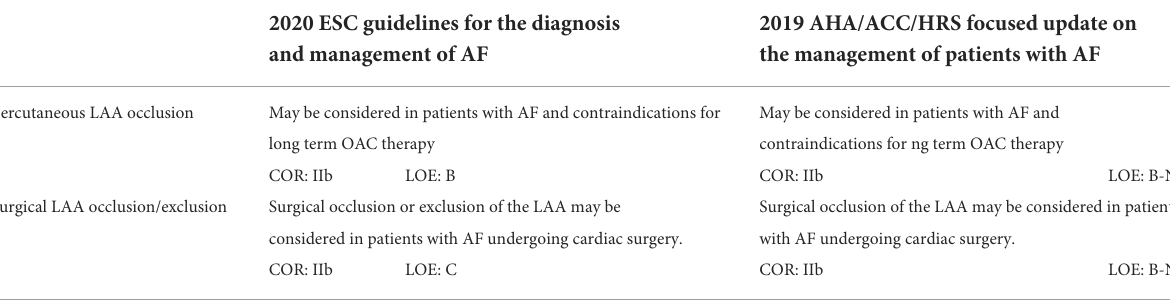
TABLE 1 Comparison of European vs. American guidelines on left atrial appendage occlusion/exclusion.